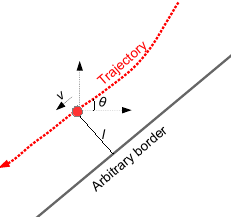
Figure 2. Attribute definitions: For a given position on a trajectory (trajectory represented by the dashed red line and a given position by the red dot), θ is absolute angle in degrees, l is the shortest distance from the border of the path (which can be arbitrarily drawn), and v is speed along the trajectory.